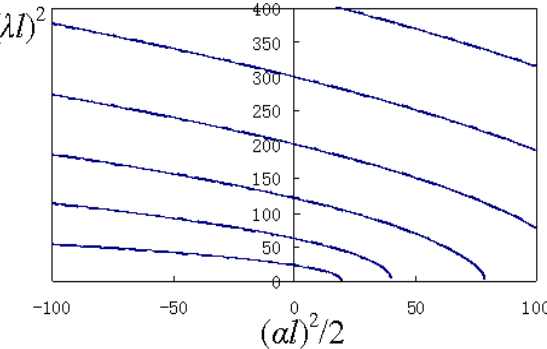
Figure 5. The relationship between (𝛼𝑙 ) 2 and (𝜆𝑙 ) 2 .